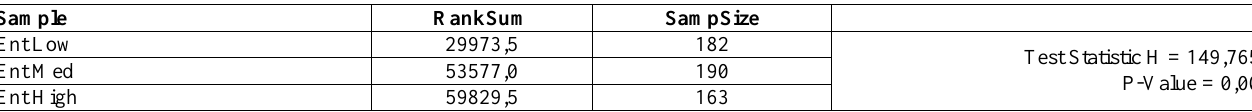
Tablw 10: Kruskal-Wallis test